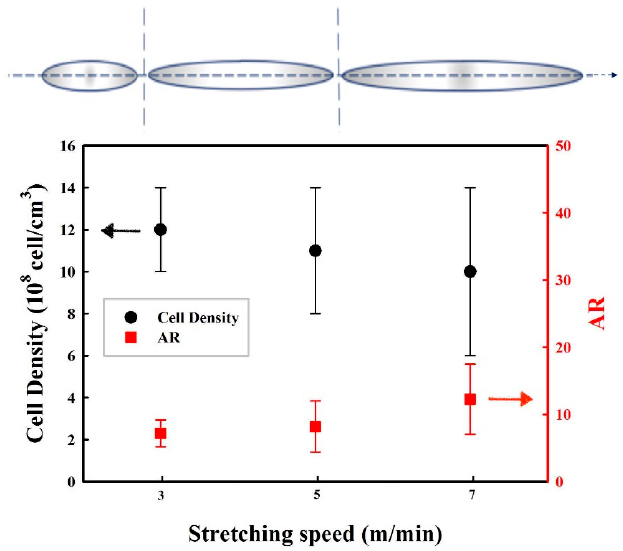
Figure 10. Effect of the stretching speed on cell density and cell aspect ratio (AR) in the flow direction for MMFM15 (2.5% CBA). for MMFM15 (2.5%